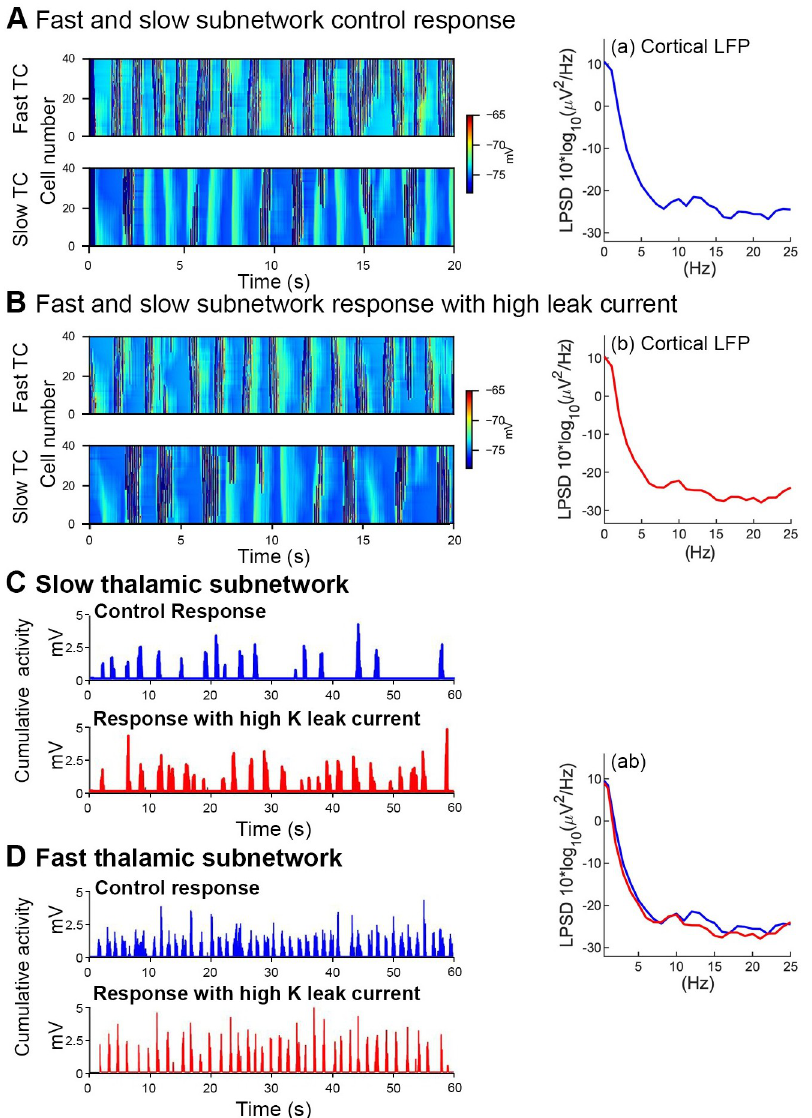
Fig 7. Influence of increased hyperpolarization of fast TC and increased potassium leak current in the fast thalamic subnetwork on spindle activity. A , Plots of fast TC and slow TC cell membrane potential (color coded, right axis) overlayed by the firing rate (left axis) during control simulation (left) and the corresponding power spectrum of cortical LFP (right; a). B , Plots of fast TC and slow TC cell membrane potential (color coded, right axis) overlayed by the firing rate (left axis) during hyperpolarization simulation (left) and the corresponding power spectrum of cortical LFP (right; b). C , In control simulations, the input from the slow thalamic subnetwork projecting to the cortical network generated only a few events (~19 events per minute; above panel, left), whereas in simulations with increased K leak current, the number of events was higher (~25 events per minute; bottom panel, left). D , In control results, The fast thalamic subnetwork exhibited stronger response in each event (~ 9 spikes in event; above panel) in control results, whereas in increased K leak these results, the event response was weaker (~ 6 spikes in event; bottom panel). ab , The resultant cortical LFP power in the slow frequency range remained the same after